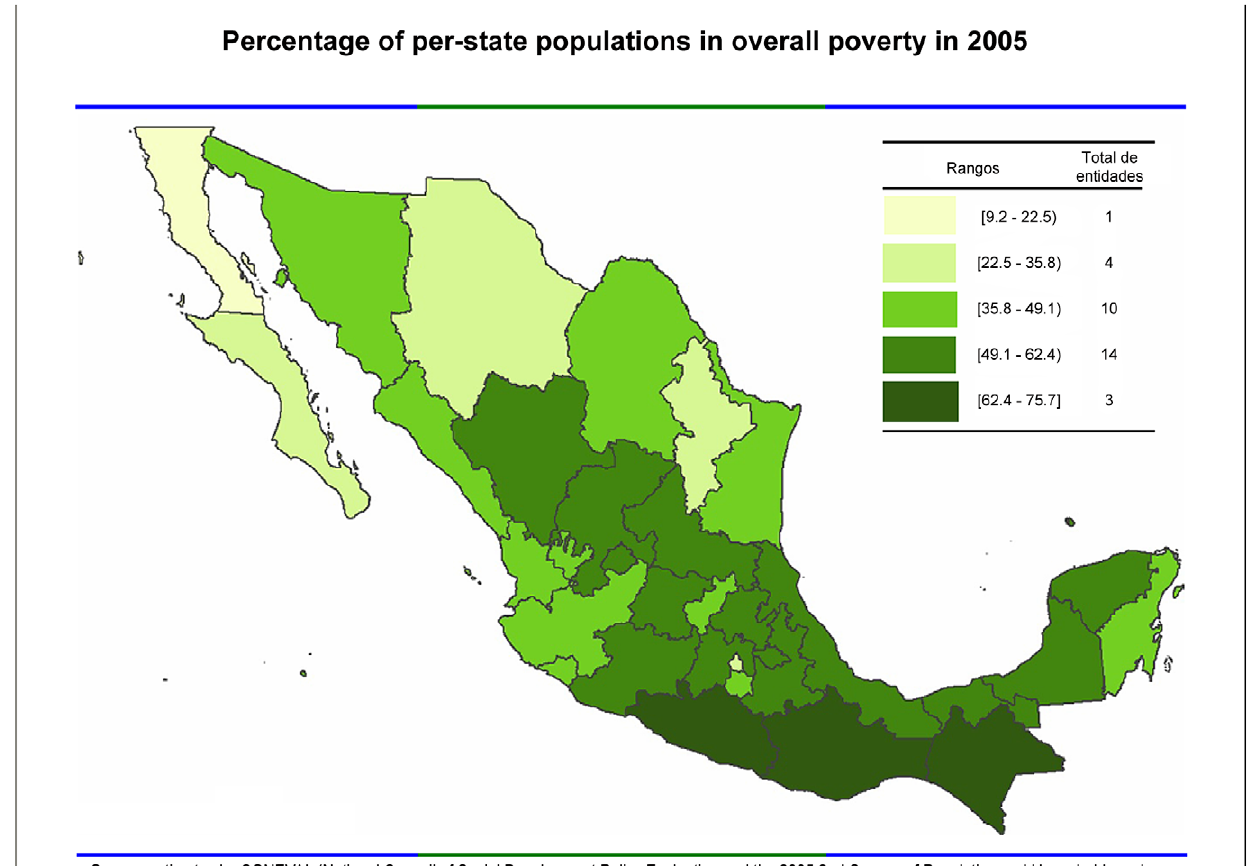
Figure 1. Poverty in Mexico by state. Map created by Usfirstgov with data from government website http://www.coneval.gob.mx/mapas/ NACIONAL/Nacional.pdf, accessed at http://en.wikipedia.org/wiki/File:Overall_Poverty.PNG March 7,